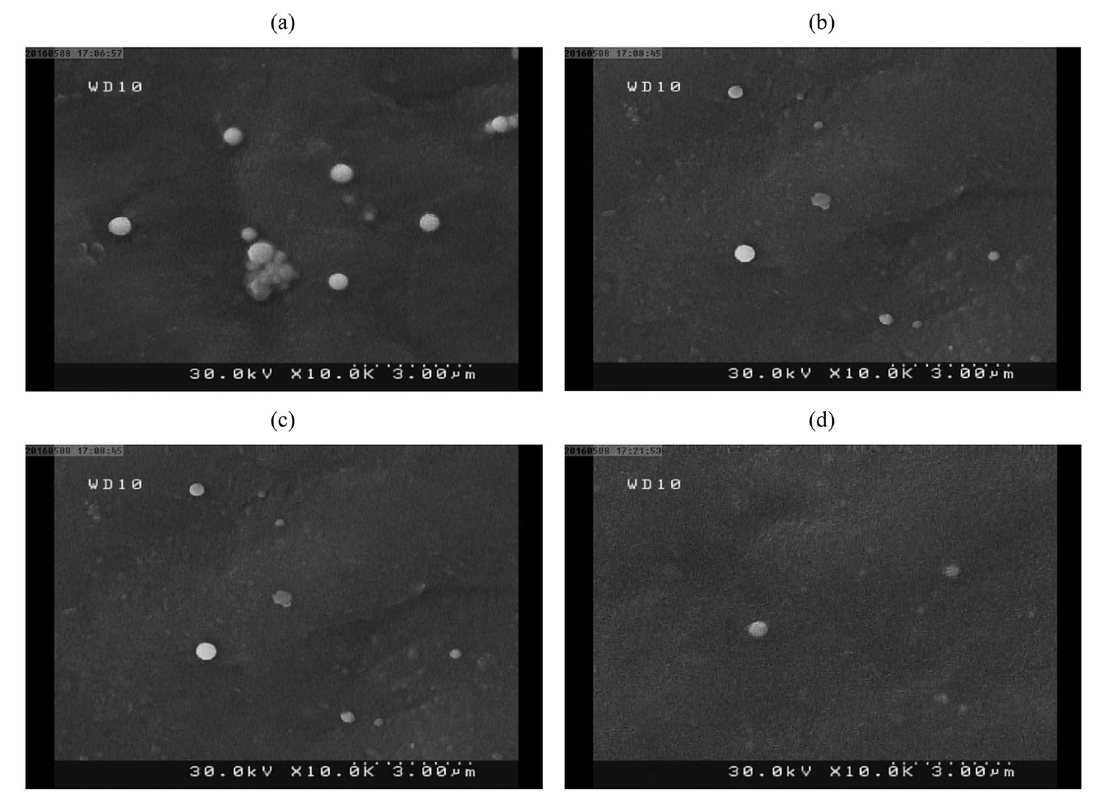
Fig. 10 SEM micrographs of Au/Ag BNPs samples dried on aluminum foil